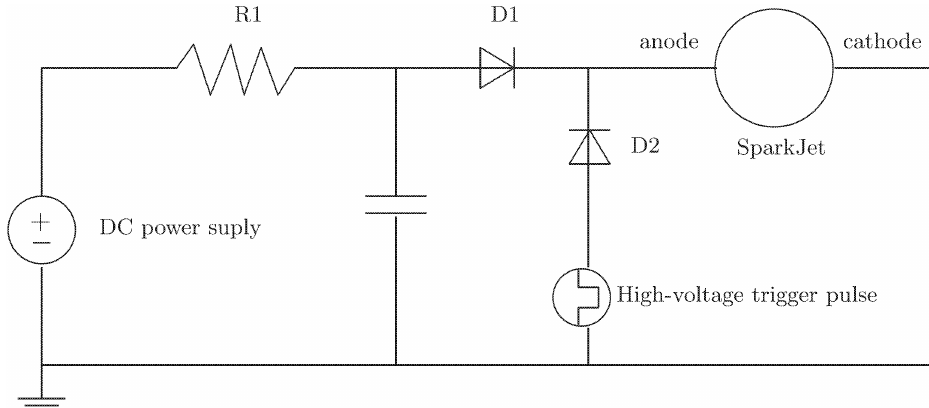
Figure 22. Electronic